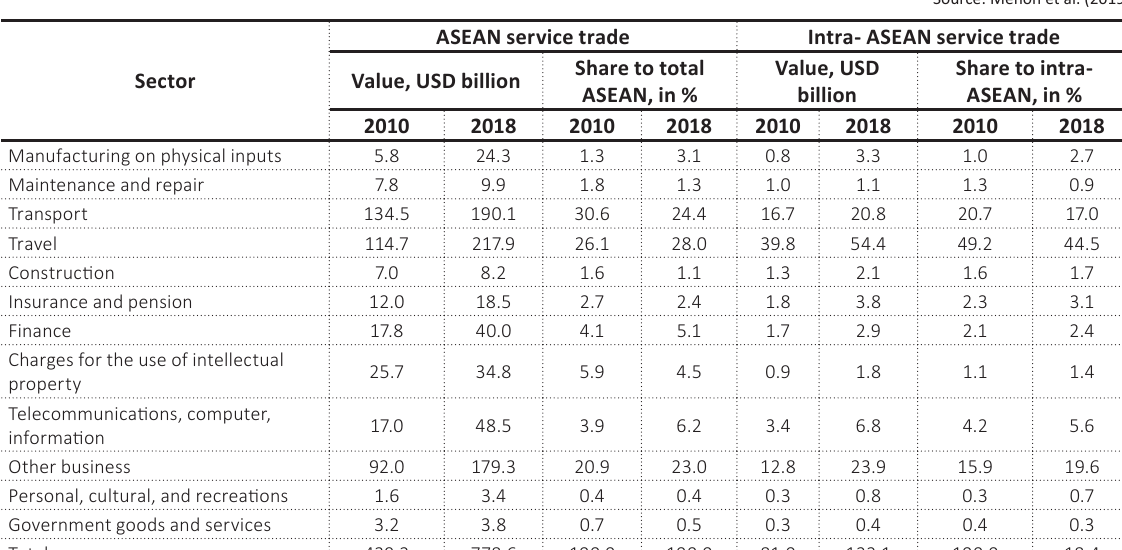
Table 3. Services sector in ASEAN and selected indicators